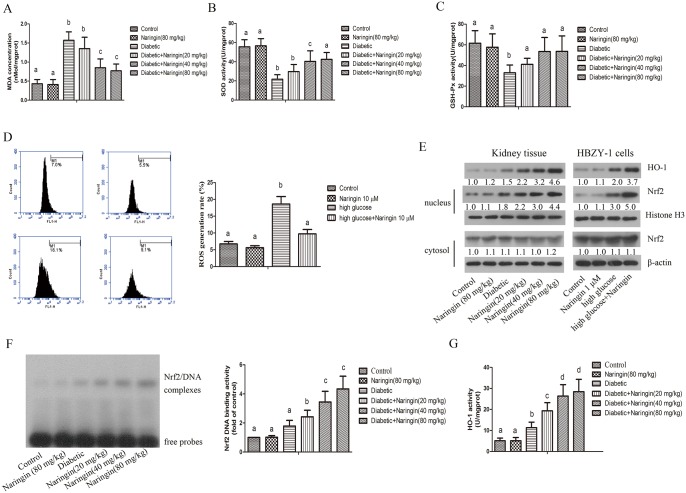
Naringin restrained oxidative stress injury by activating Nrf2 antioxidant pathway.The concentration of MDA (A), the activity of SOD(B) and GSH-Px(C) in kidney tissues were detected. Data were expressed as means ± SD, n = 6. (D) The ROS production in HBZY-1 cells was evaluated by flow cytometry and ROS generation rates were shown. Data were expressed as means ± SD, n = 3. (E) The protein levels of Nrf2 and HO-1 in kidney tissues or HBZY-1 cells were detected by western blot. Results represent three independent experiments. (F) The DNA binding activities of Nrf2 in kidney tissues were assessed by EMSA assay. Data were expressed as means ± SD, n = 5. (G) The HO-1 activities in kidney tissues were determined. Data were expressed as means ± SD, n = 6.a-d Means with different superscripts are significantly different (P< 0.05).